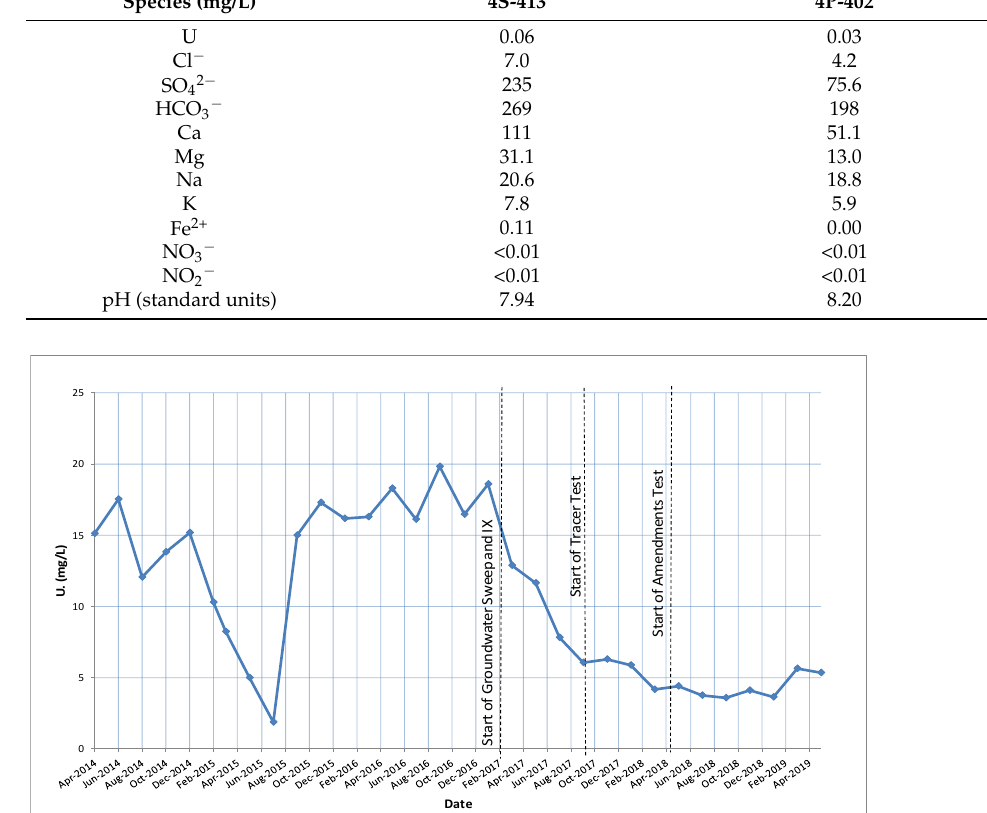
Figure A1. Uranium concentrations in well 4P-216 as a function of time. Dashed lines show the start of groundwater sweep and ion exchange, start of the tracer test, and start of the amendments test.